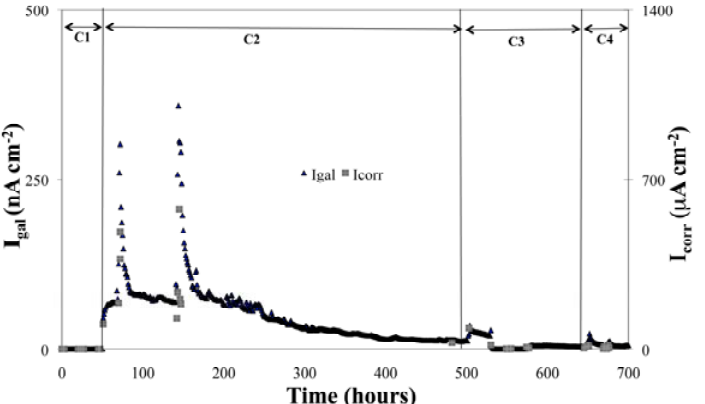
Figure 5 . I and I as a function of immersion time, under the conditions C1 to gal corr